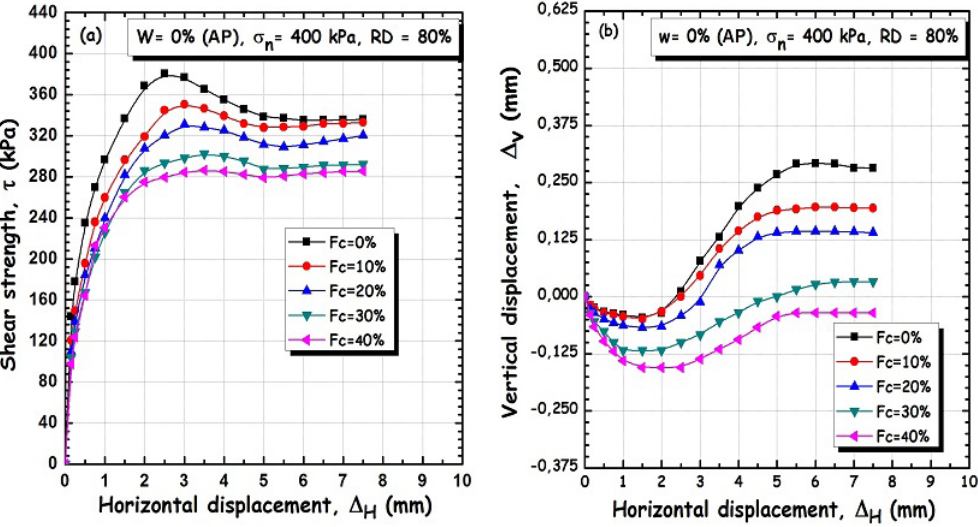
= 400 kPa): (a) variation of the shear n